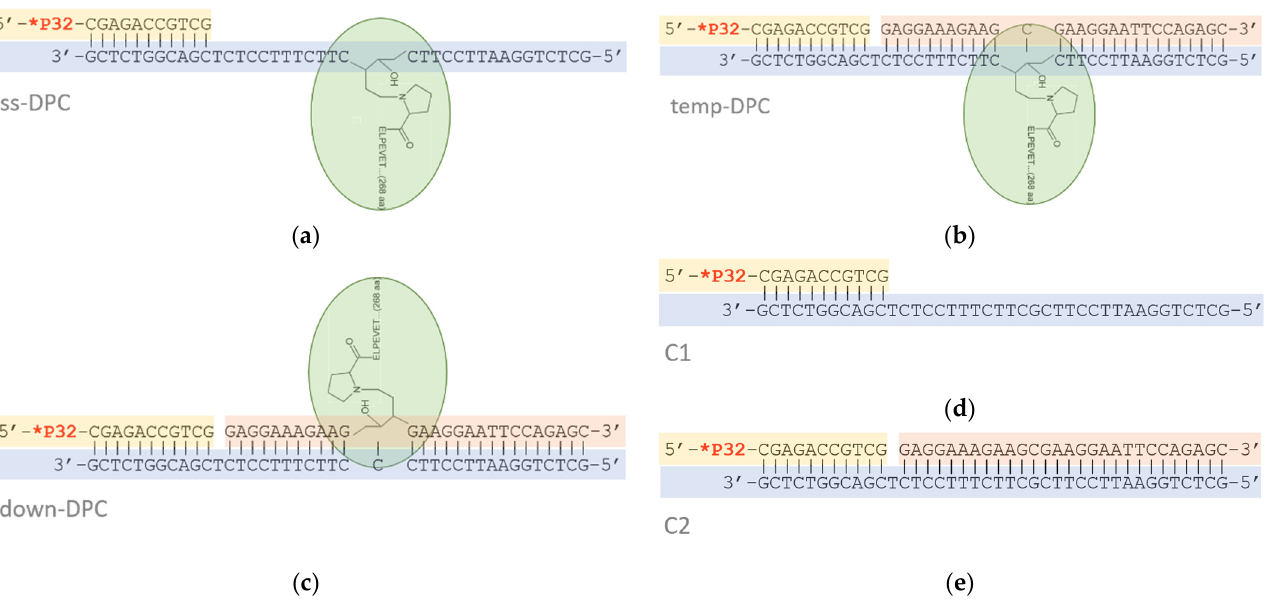
Figure 1. Schemes of the model substrates. ( a ) ss-DPC, ( b ) temp-DPC, ( c ) down-DPC, ( d ) control C1, ( e ), control C2. Fpg protein (green) is cross-linked to DNA through the reduced Schiff base with Pro1. The primer is 32 P-labeled.